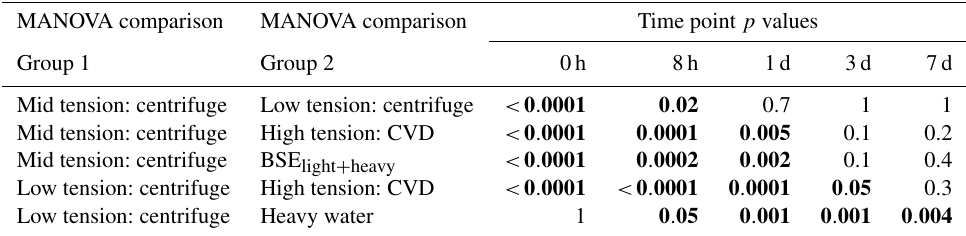
Table 2. The results of pairwise MANOVA tests for the experiment with comparisons between groups of samples; group 1 compared to group 2 is shown in the respective rows. Significant values are highlighted in bold ( p value ≤ 0 . 05). Only comparisons that changed from significant to insignificant or vice versa throughout the experiment are shown; the 16 comparisons that either remained significant or insignificant for all time points can be found in the Appendix (Table